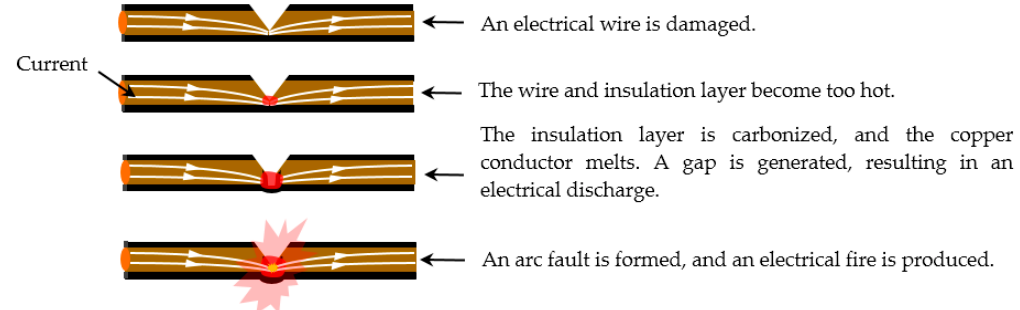
Figure 1. An electrical fire resulting from an arc fault.